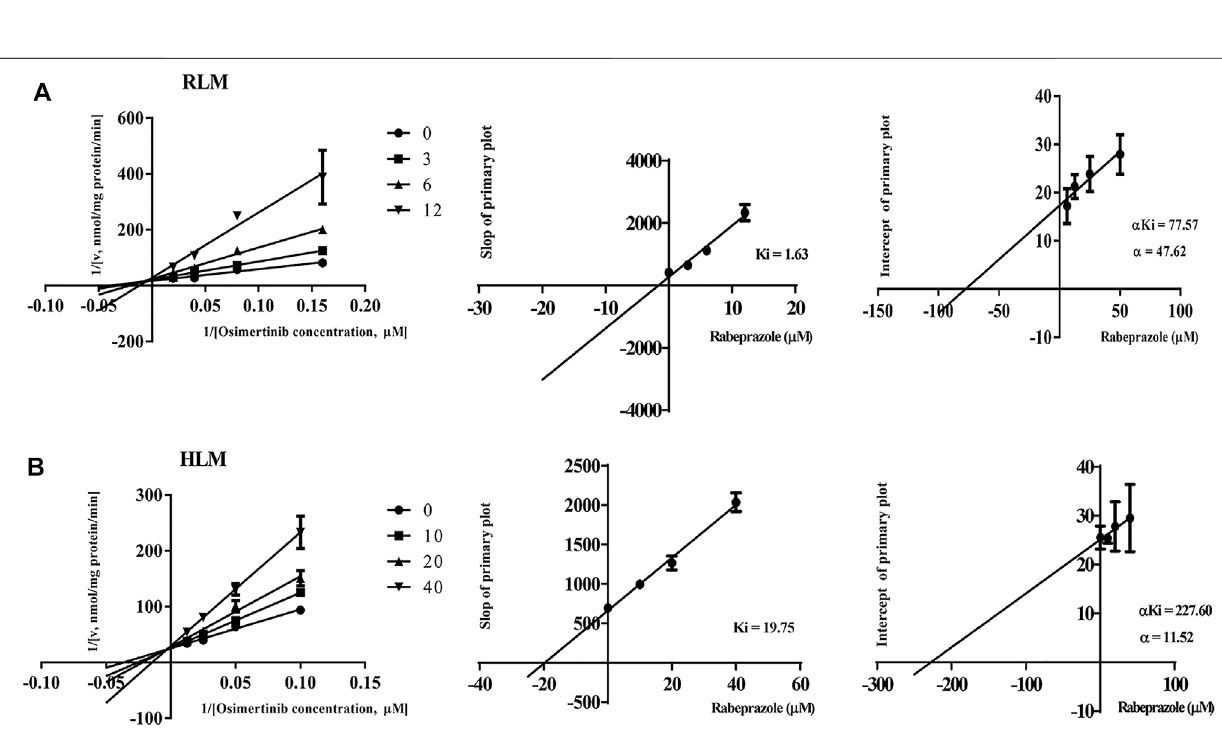
Frontiers in Pharmacology |